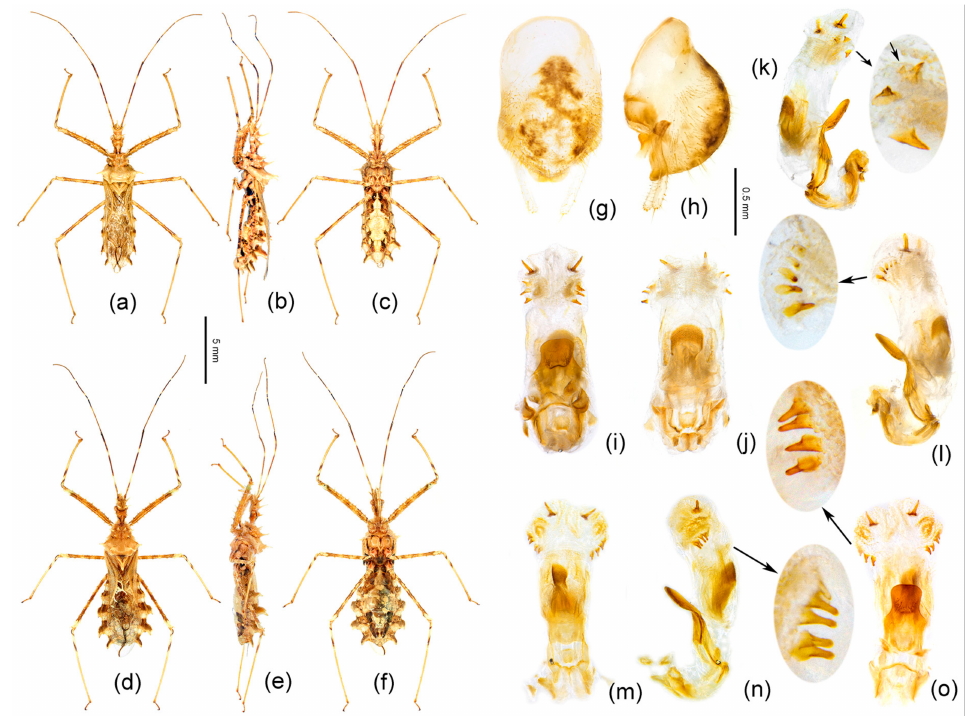
Figure 9. Sclomina pallens sp. nov., ( a – c ) male, ( d – f ) female, GZAL, habitus; ( g – l ) male, GXAL, male external genitalia; ( m – o ) male, GXTL, male external genitalia. ( g , h ) pygophore with paramere; ( i – o ) phallus. ( a , d , i , o ) dorsal view; ( b , e , h , k , l , n ) lateral view; ( c , f , g , j , m ) ventral view. Scale bar ( a – f ) = 5 mm, ( g – o ) = 0.5 mm. The subapical spines of ( k , l , n , o ) are enlarged. S. pallens sp. nov. is most similar to S. xingrensis sp. nov. in general body shape